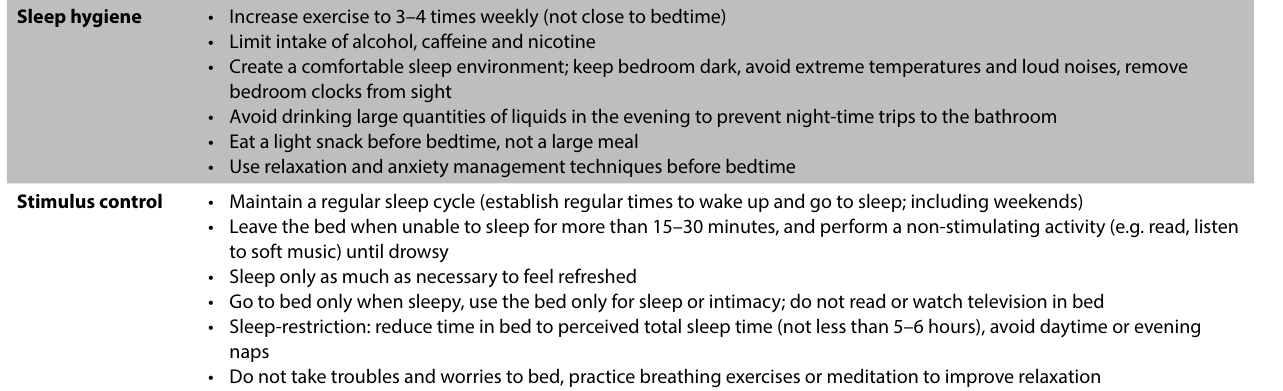
Table 3: Components of cognitive behavioural therapy for management of insomnia disorder 5-6,15,28 Sleep hygiene